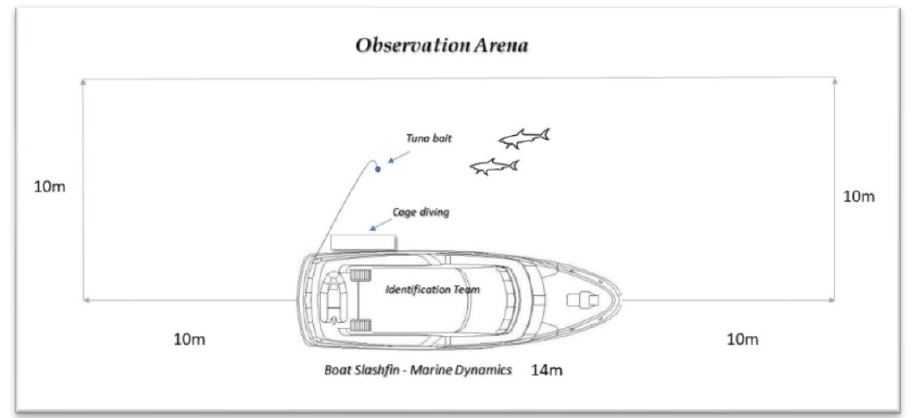
Figure 2. Virtual “ observation arena ” based on “Slashfin”, the 14 m long boat (Marine Dynamics).